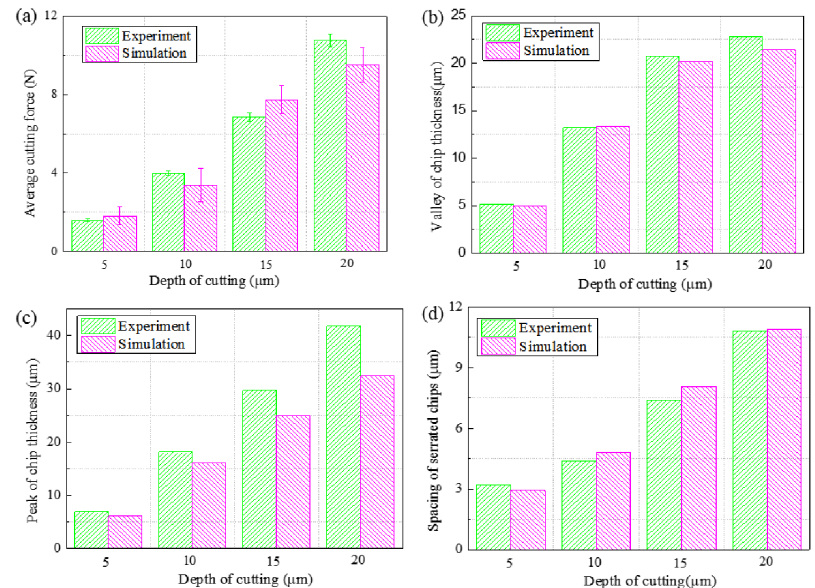
Figure 12. Comparison of the experimental and simulation results at different depths of cut; ( a ) aver- age cutting force, ( b ) valley of chip thickness, ( c ) peak of chip thickness, ( d ) spacing of serrated